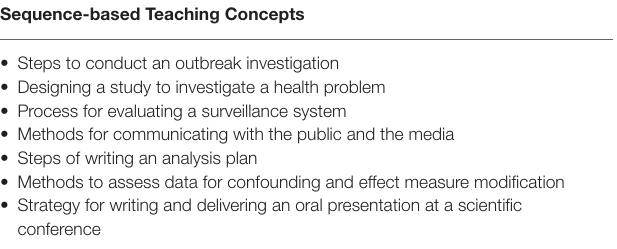
TABLE 2 | Examples of concepts that can be given a clear sequence or structure for teaching purposes. Sequence-based Teaching